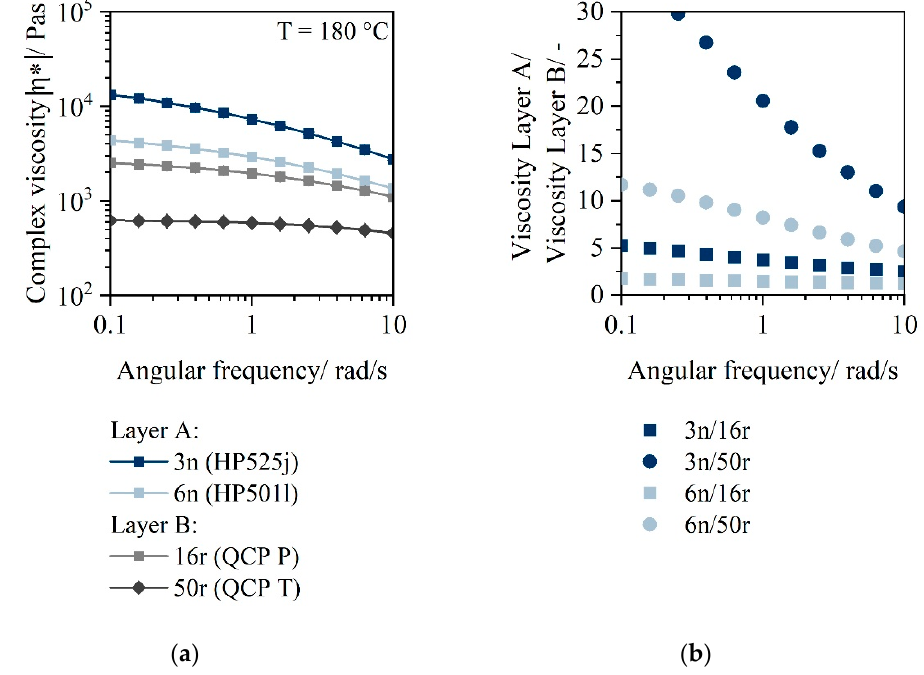
Figure 4. Complex viscosity of the materials 3n (HP525j), 6n (HP501l), 16r (QCPP) and 50r (QCPT) ( a ); viscosity ratio between layer material A and layer material B at low angular frequencies ( b ) .